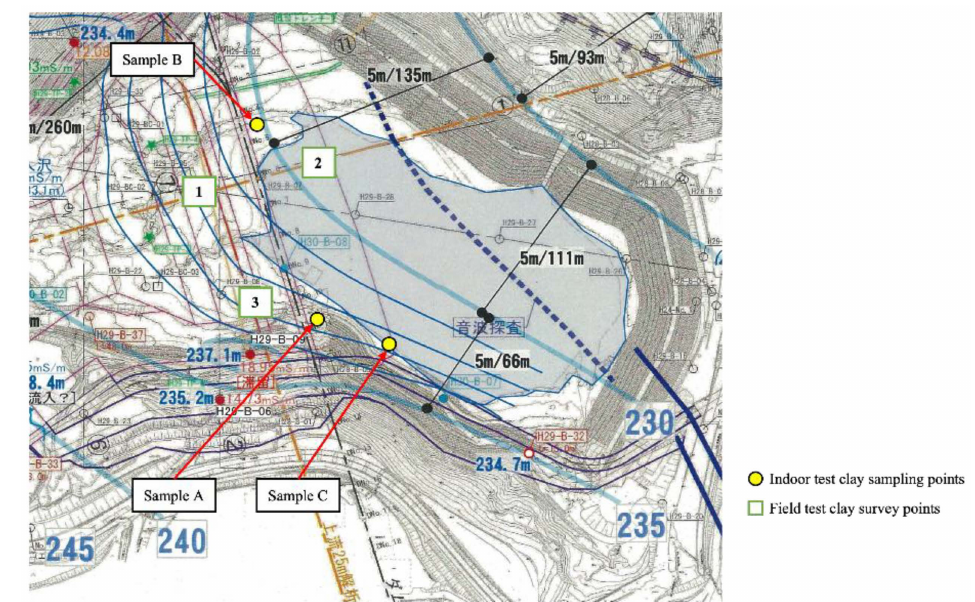
Figure 1. Locations where dynamic cone penetration test and water content measurement were performed; sampling position of Kumamoto clay.